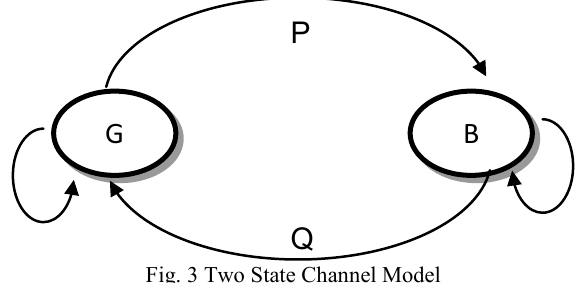
Fig. 3 Two State Channel